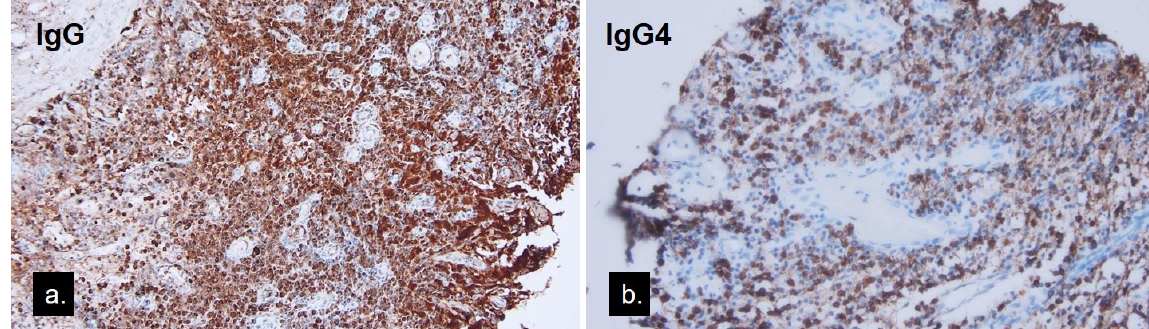
Figure 5. ( a ) Immunohistochemical stain of the lesion using an anti-IgG antibody ( b ) and anti-IgG4 antibody showing the high ratio of IgG4-positive cells against IgG-positive cells exceeding 40%.